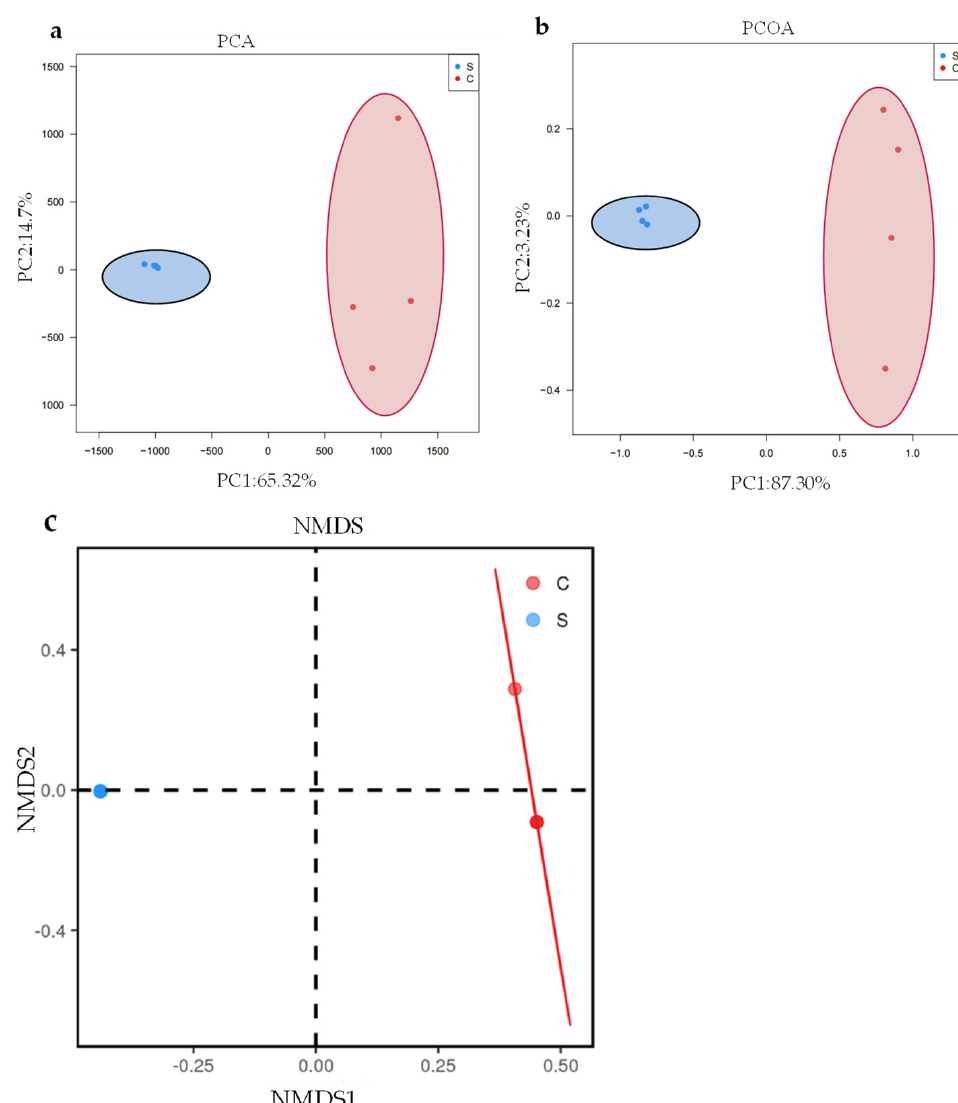
Figure 4. Box-whisker plot for the group distances.